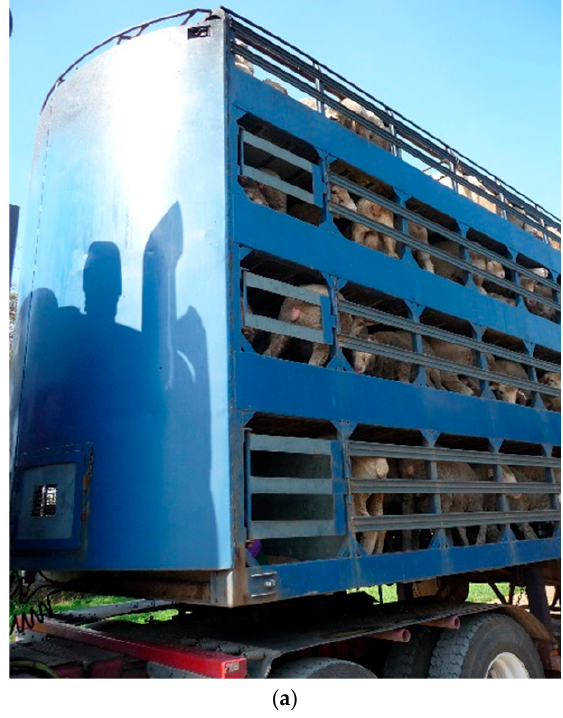
Figure 1. Schematic diagram of vehicle designs ( a ) standard and ( b ) convertible crates.